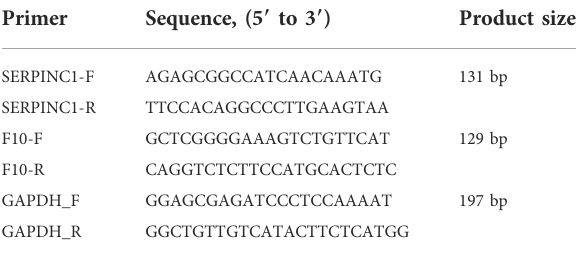
TABLE 1 Primer information table for fl uorescence quantitative AT-III and FX gene mRNA detection. Primer Sequence, (5 9 to 3 9 ) Product size